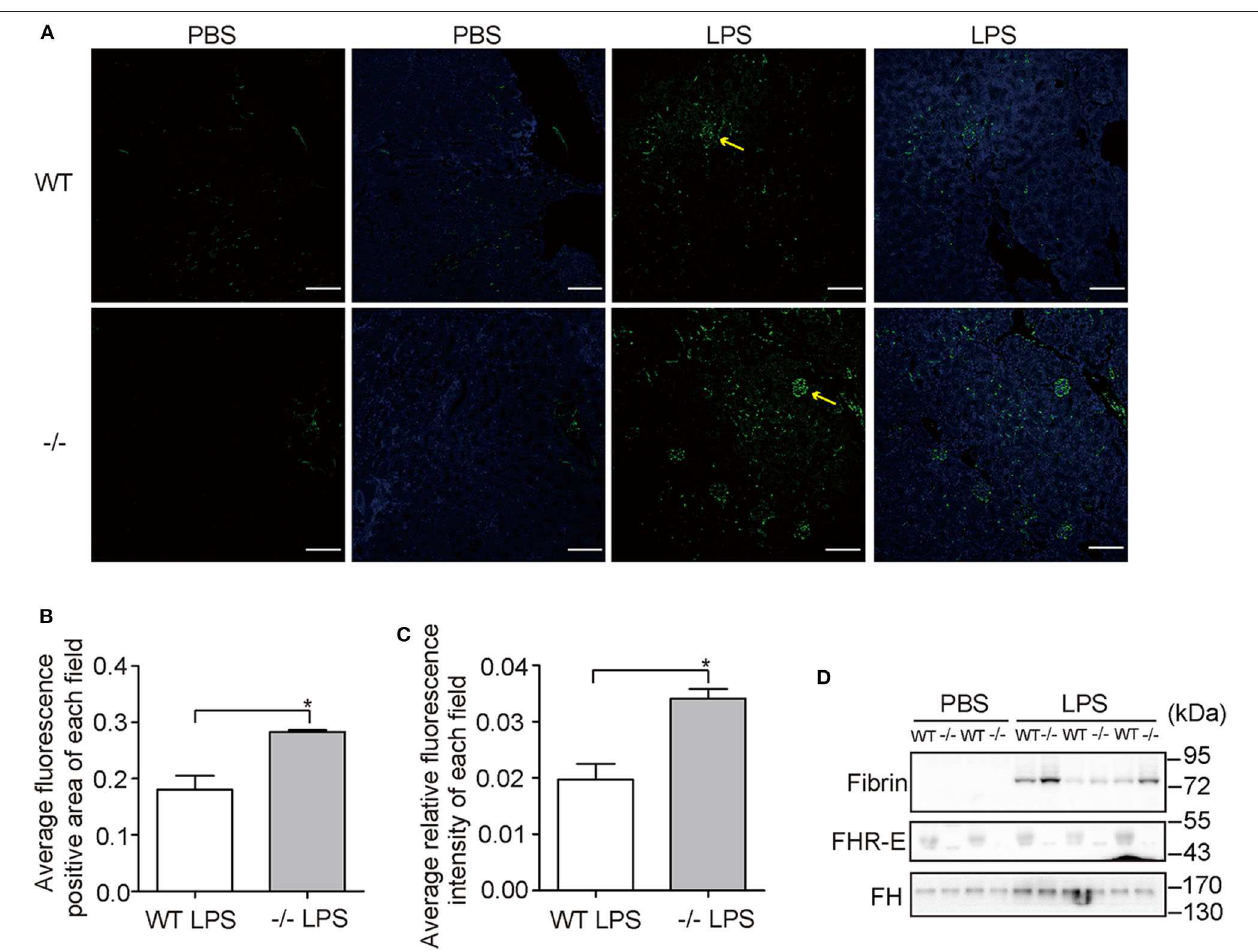
FIGURE 8 | Vascular damage examinations. Three mice in each group were used. (A) Immunostaining of fibrin on kidney sections. Pictures were taken at a magnification of 200 × . The green signals indicate fibrin. The blue signals indicate total nuclei stained with DAPI. Arrows point to the fluorescence positive area. The bar is 50 µ M. (B) Comparison of fluorescence positive area between WT and Cfhr1 − / − mice. Fluorescence positive area of each field was calculated by Image J. Twenty non-overlapped fields were counted and averaged. (C) Comparison of fluorescence intensity between wild-type and Cfhr1 − / − mice. Fluorescence intensity of each field was calculated by Image J. Twenty non-overlapped fields were counted and averaged. (D) Western blotting analysis of plasma fibrin of 12h after LPS challenge. Western blotting of FHR-E was performed to determine the genotypes. Equal volumes of plasma were loaded. The Western blotting of FH on the same blot was regarded as an internal control. * p <